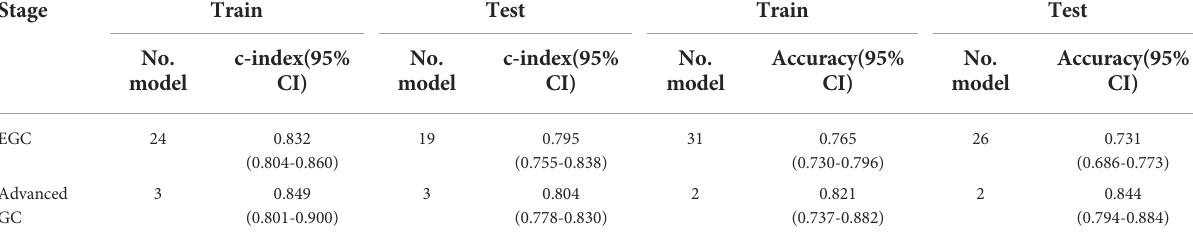
TABLE 5 Subgroup analysis for early-gastric cancer and advanced gastric cancer.